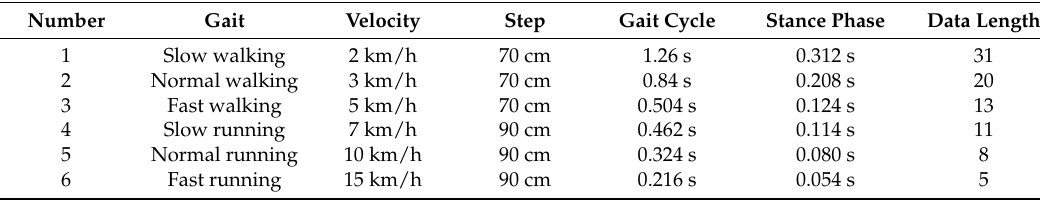
Table 1. Statistics of gait characteristics.